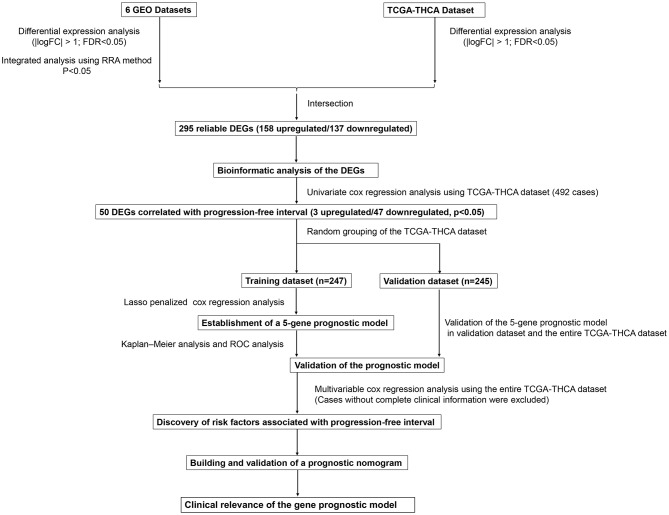
Flowchart presenting the process of establishing the five-gene signature and prognostic nomogram for papillary thyroid carcinoma (PTC).